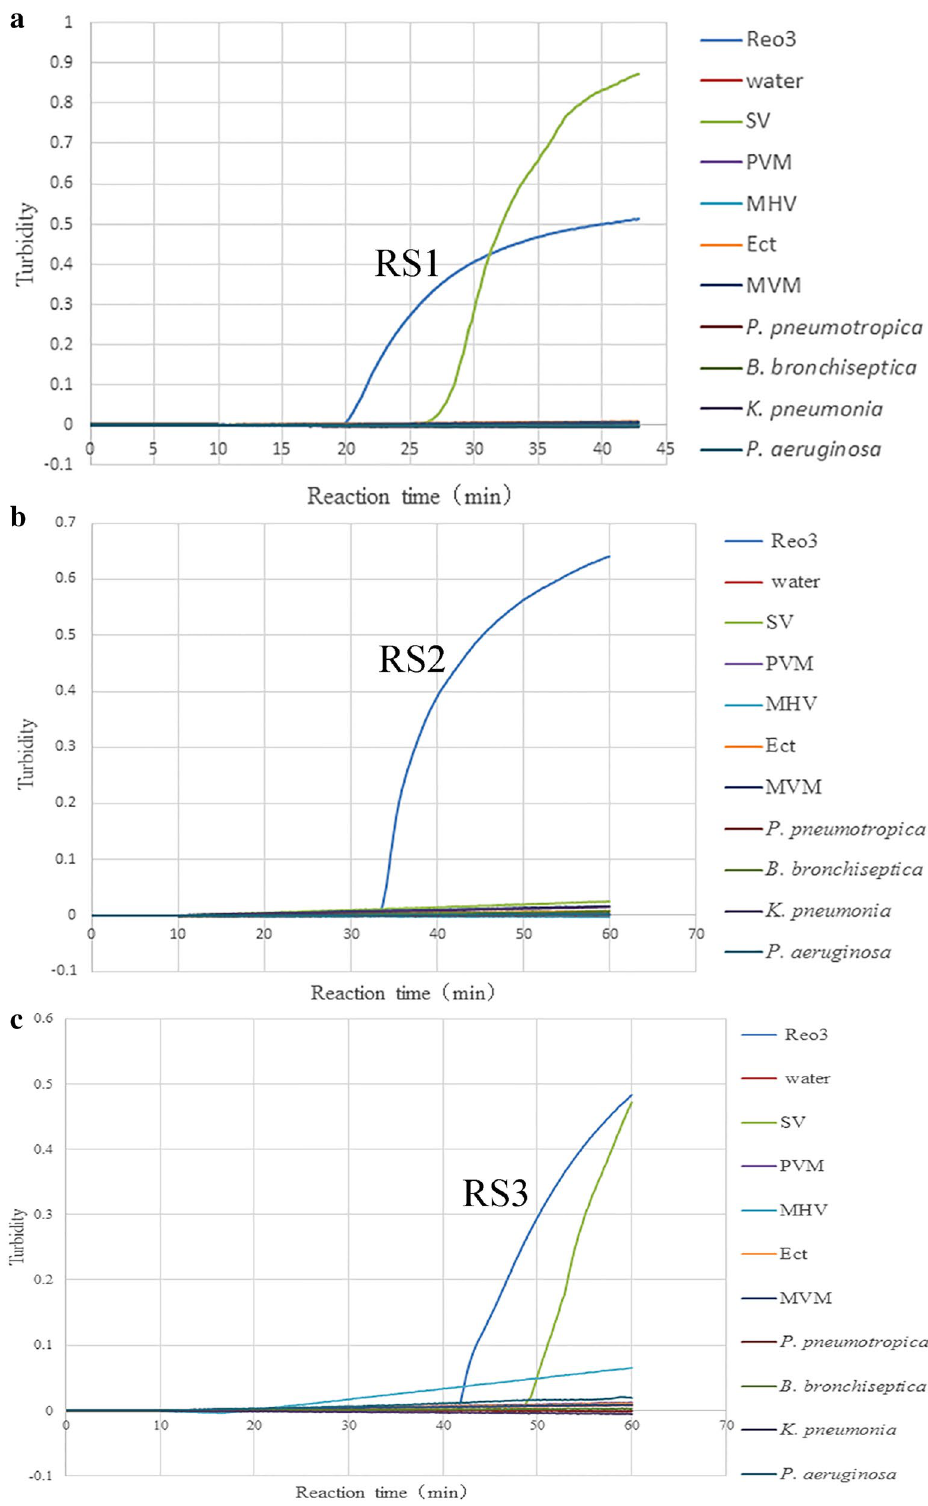
Figure 1. Primer set optimization test for RT-LAMP assay by using Loopamp real-time turbidimeter. ( a ) RS1 turbidity curve for the tests of the Reo-3, SV, PVM, MHV, Ect, MVM, P. pneumotropica , B. bronchiseptica , K. pneumonia , P. aeruginosa and water, the turbidity curve was plotted using the software based on the Loopamp Realtime Turbidimeter.; ( b ) RS2 turbidity curve for all tests; ( c ) RS3 turbidity curve for all